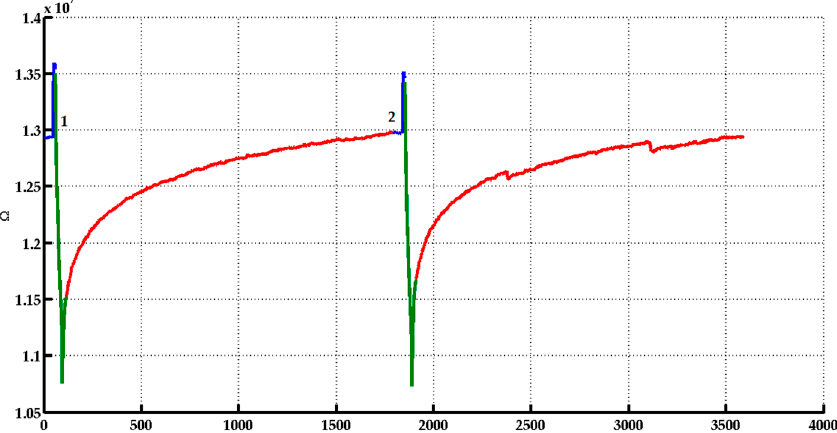
Figure 2. Graph showing the three steps of a measurement done with a MOX Nanowire SnO 3 sensor, with before step in blue, during step in green, and after step in red. In the picture are represented two measurements of two cheese samples with 12 months of ripening and undegraded quality. The X-axis represents the time in seconds and the Y-axis the ohmic resistance.